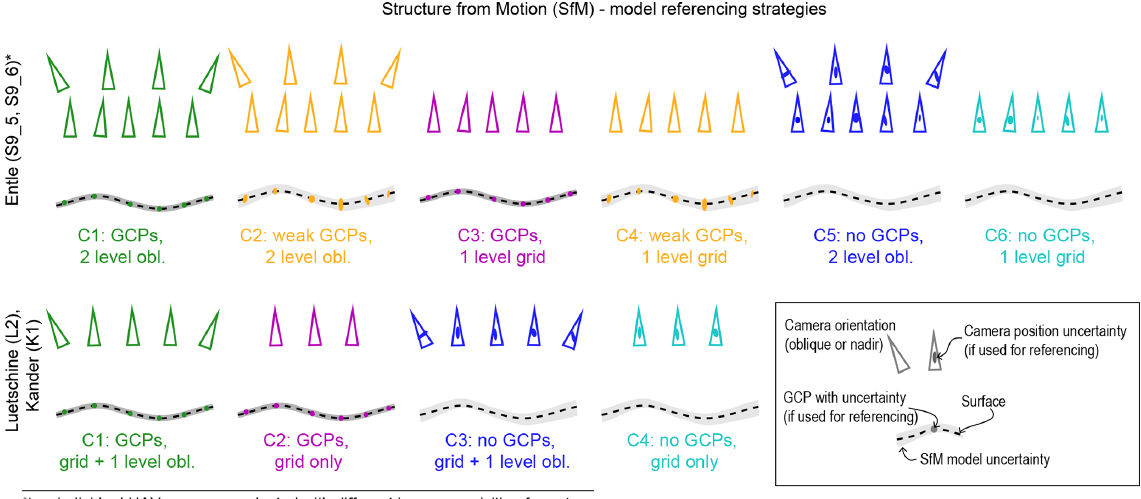
Figure 2. Strategies for UAV surveys and structure from motion (SfM) model setups (upper row: Entle surveys; lower row: Luetschine and Kander surveys). We used a one-level grid of nadir camera positions as backbone geometry, which we complemented with oblique angle camera positions (James and Robson, 2014). At the Entle (S9), we took nadir images at a second altitude (e.g., Carbonneau et al., 2018). We created different models during processing by first including all images and GCPs (i.e., resulting in models with “C1” labels) and then leaving out the oblique images or the GCPs. For the Entle (S9) models we also tested the option where we used the GCP targets in the images as reference markers only, resulting in two additional models that are labeled with “C2” and “C5”. Colors indicate similar model strategies. For flight altitude and nominal camera angles, see Table 1. GCPs: ground control